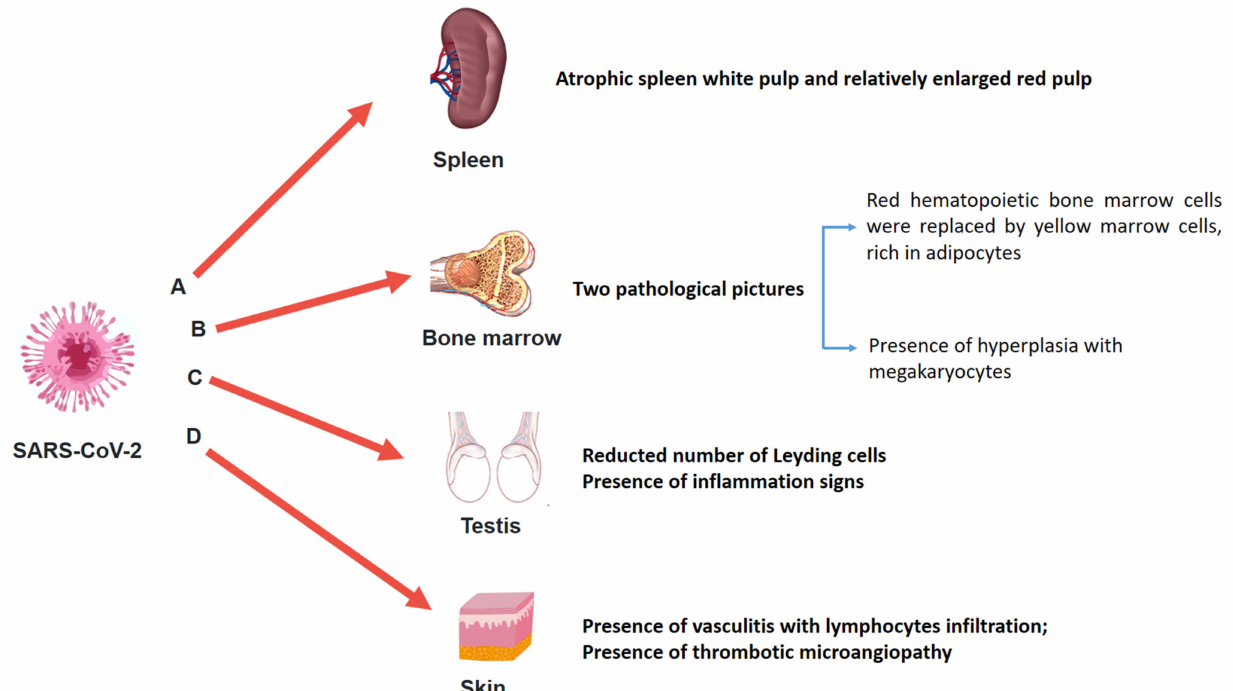
Figure 3. Different organs such as spleen, bone marrow, testis, and skin should be better studied. Nevertheless, in this picture, the main adverse effects of SARS-CoV-2 on spleen ( A ), bone marrow ( B ), testis ( C ), and skin ( D ) are